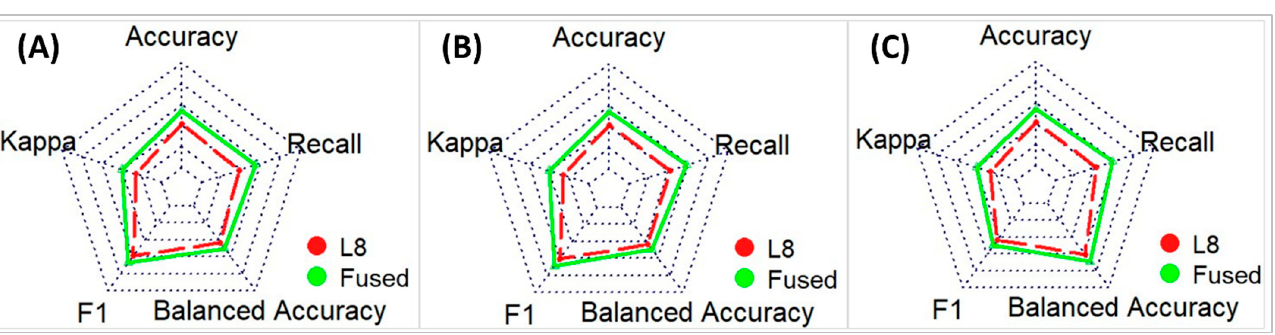
Figure 12. Spider plot for quantitative evaluation of fusion methods using the confusion matrix between a reference classification map and classification maps obtained by different NDSI thresholds ( A ) for threshold = 0.3, ( B ) for threshold = 0.35, and ( C ) for threshold = 0.4.